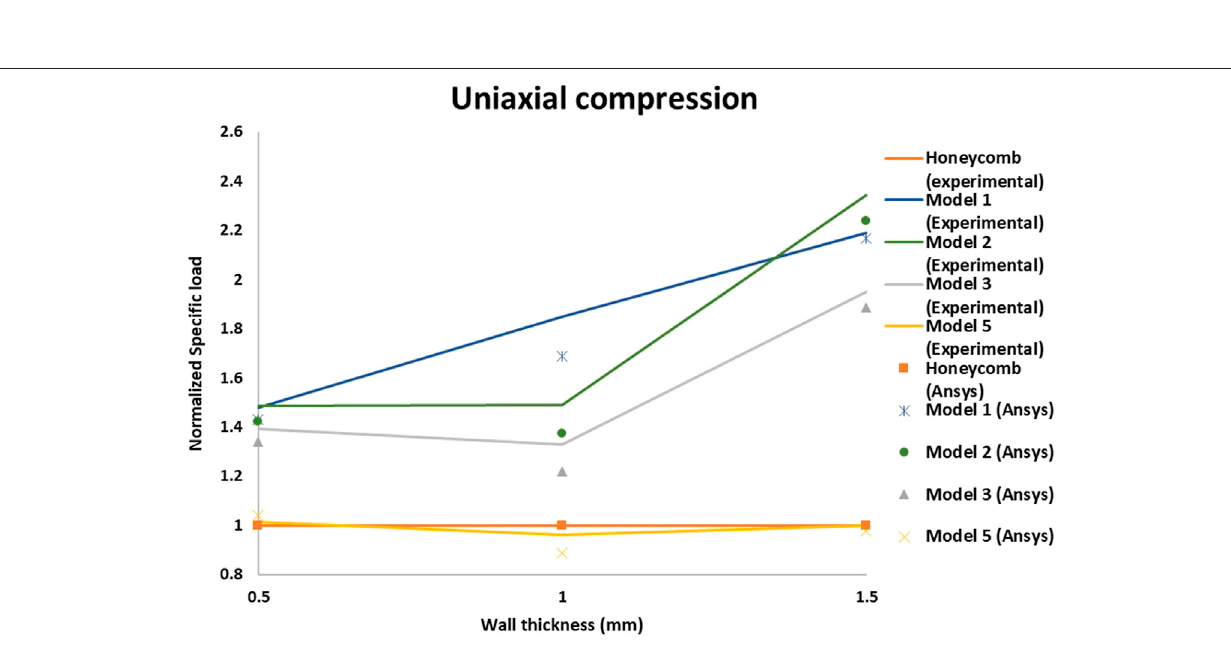
Frontiers in Mechanical Engineering |